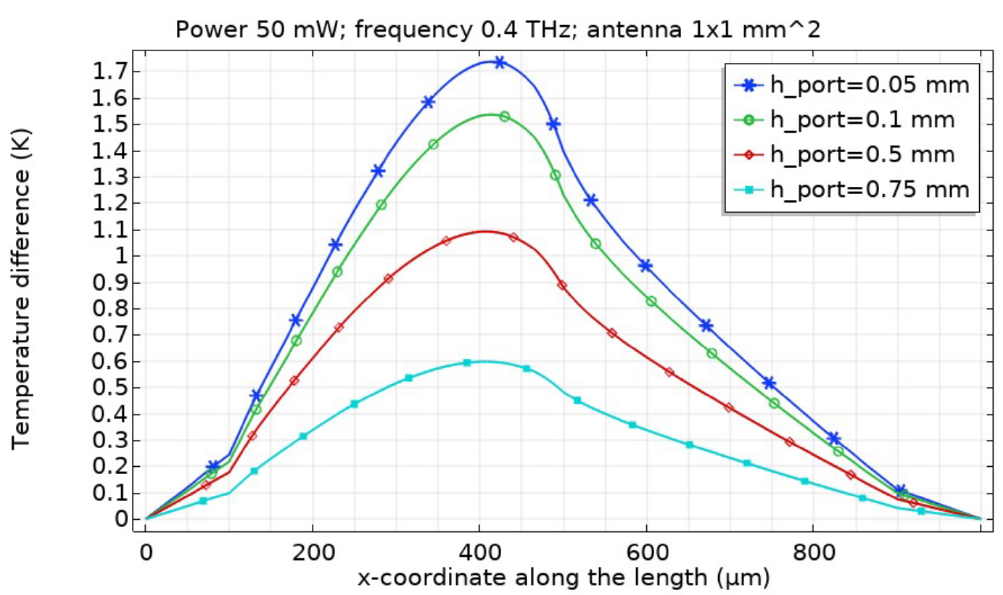
Figure 6. Example of temperature distribution along the x-axis (antenna length). Copper films correspond to the x-coordinates: 0–100 µ m, Bi 88 Sb 12 to 100–500 µ m, Sb to 500–800 µ m; hot junction corresponds to the x-coordinate at 500 µ